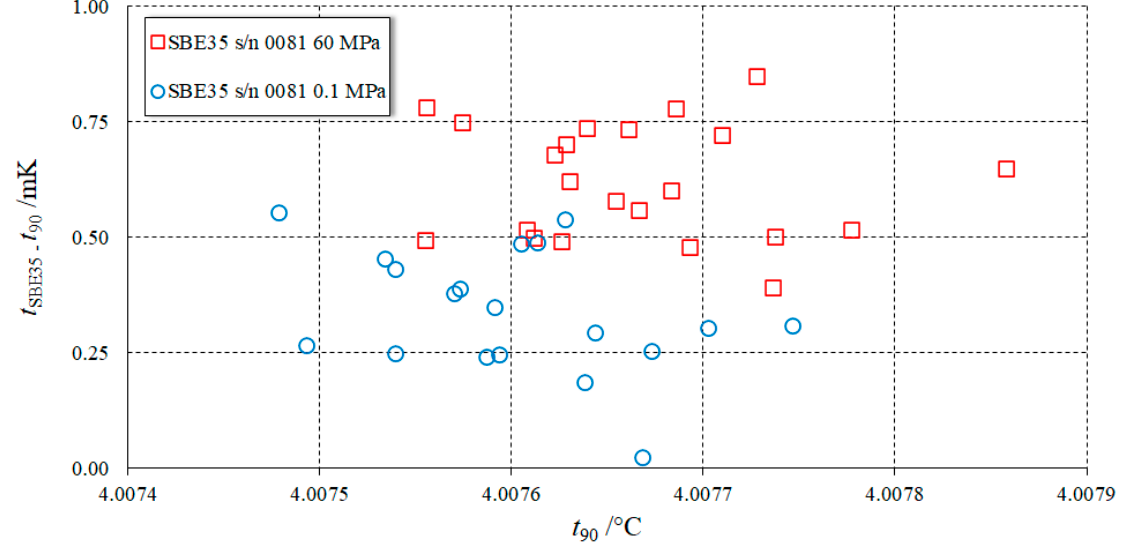
Figure 11. Temperature difference between the SBE35 reading, t SBE35 , and the water bath reference temperature, t 90 , as a function of t 90 for two SBE35 units (s/n 0015 and s/n 0081).